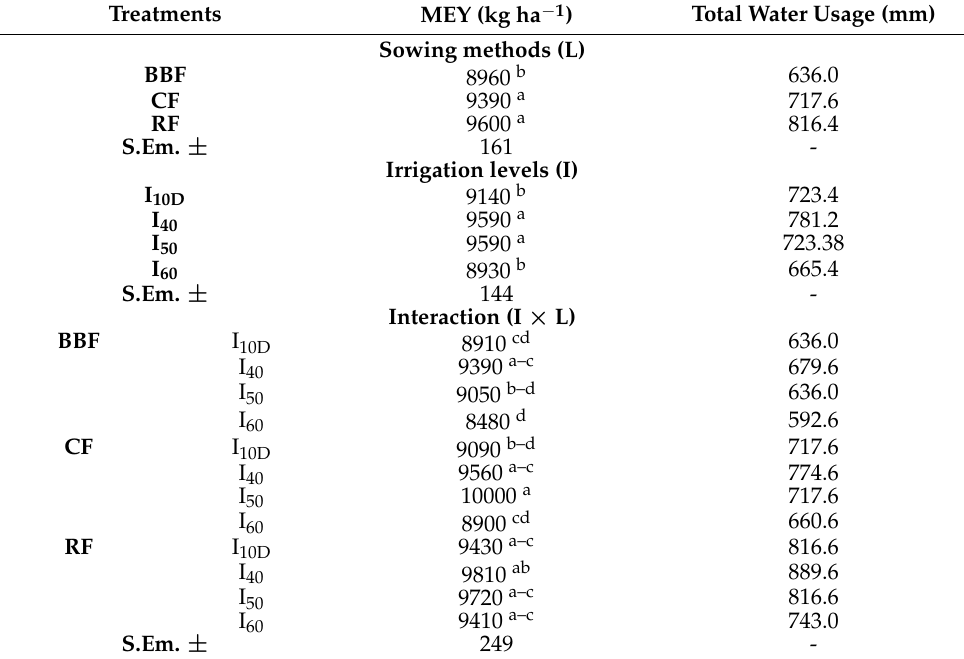
Table 7. Maize equivalent yield of cowpea (MEY) and total water usage of maize–cowpea system under different sowing methods and irrigation levels (pooled data of 2015 and 2016).